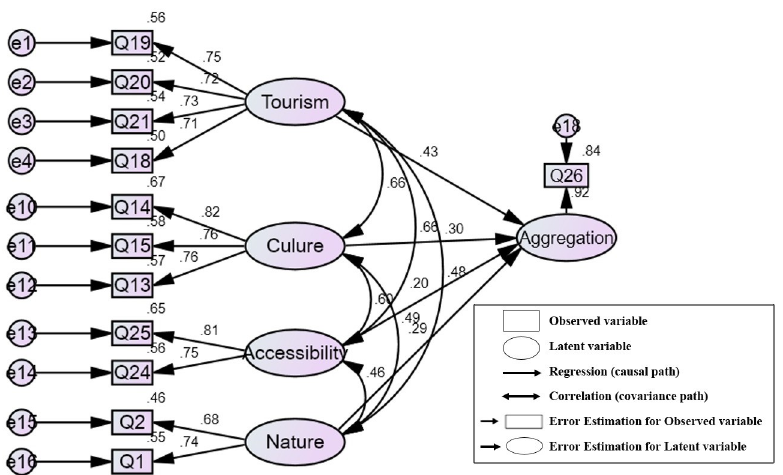
Fig 4. Structural model parameters for modeling the overall assessment of aggregation landscape values ( χ 2 / df = 3.381, GFI = 0.927, TLI = 0.908, CFI = 0.934, RMSE = 0.084).